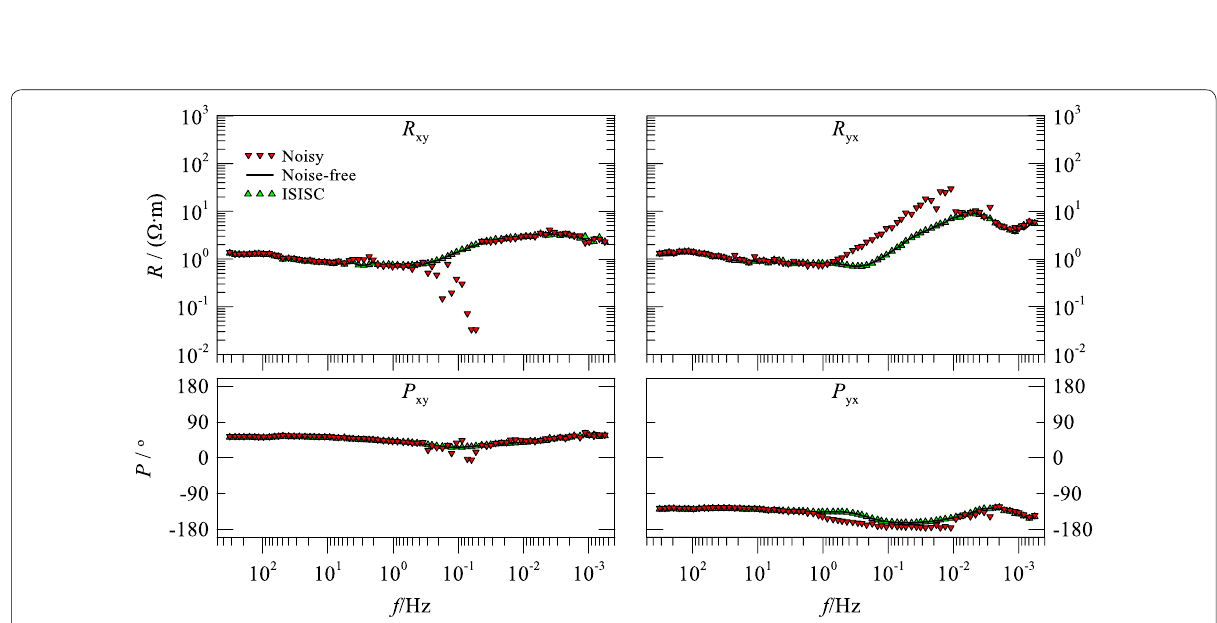
Fig. 9 Apparent resistivity and phase curves of the station QH401504. The upper panels are apparent resistivity curves and the bottom panels are phase curves. The red curves denote the results obtained by all the raw data sets D 1 and D 2 ; the solid lines represent the results obtained using noise-free data set D 2 ; the green curves stand for the results achieved by data sets D 1 and D 2 , but is de-noised by our new